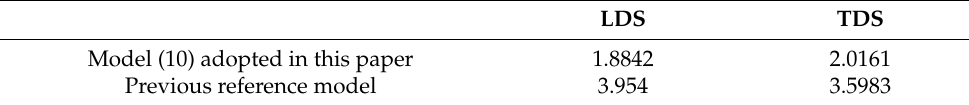
Table 7. RMSE [L/s] of HTs total water loss.